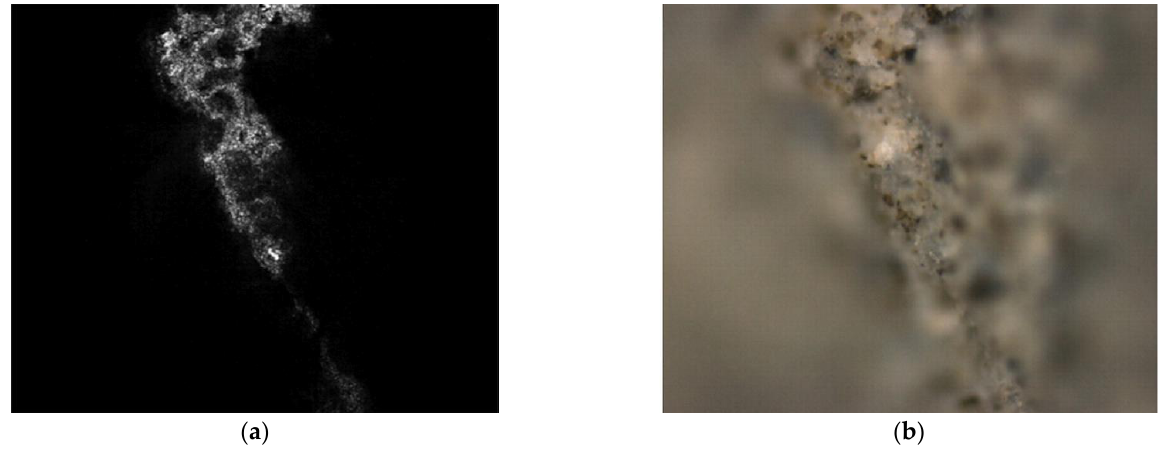
Figure 1. Optical cut of fracture surface of hydrated cement paste acquired by confocal microscope Olympus LEXT 1000. Confocal mode ( a ), standard mode ( b ). Taken from [24]).